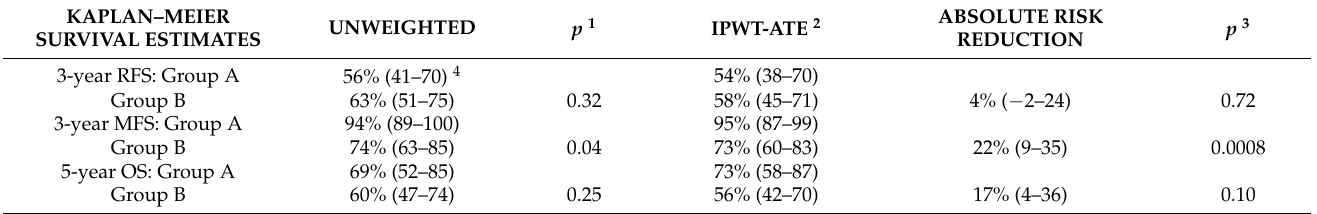
Table 2. Kaplan–Meier estimates of cumulative survival in patients treated with cetuximab + radio- therapy or with up-front surgery + radiochemotherapy.